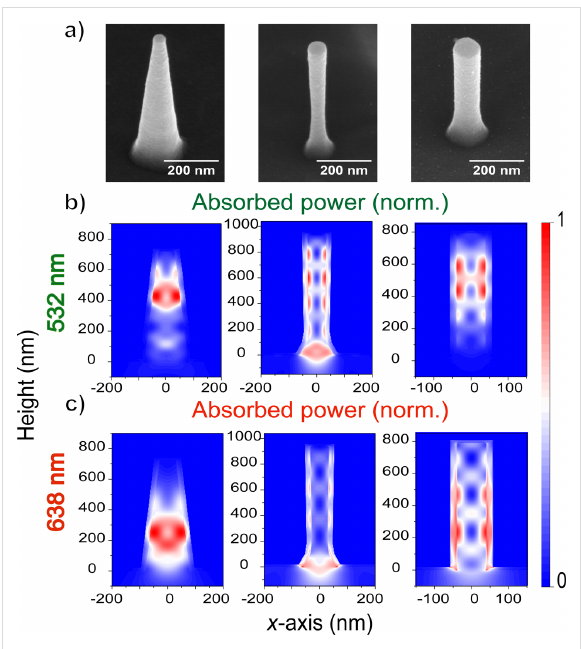
Figure 2: (a) SEM images of a silicon nanocone (left), an inverted nanocone (middle) and a nanowire (right) coated with an 18 nm TiO 2 layer. The tapering angle was controlled by varying the Cl 2 and HBr/O 2 flow rates during plasma etching. (b, c) FDTD simulations of absorbed power in each nanostructure at (b) 532 nm and (c) 638 nm normalized to the maximum value.